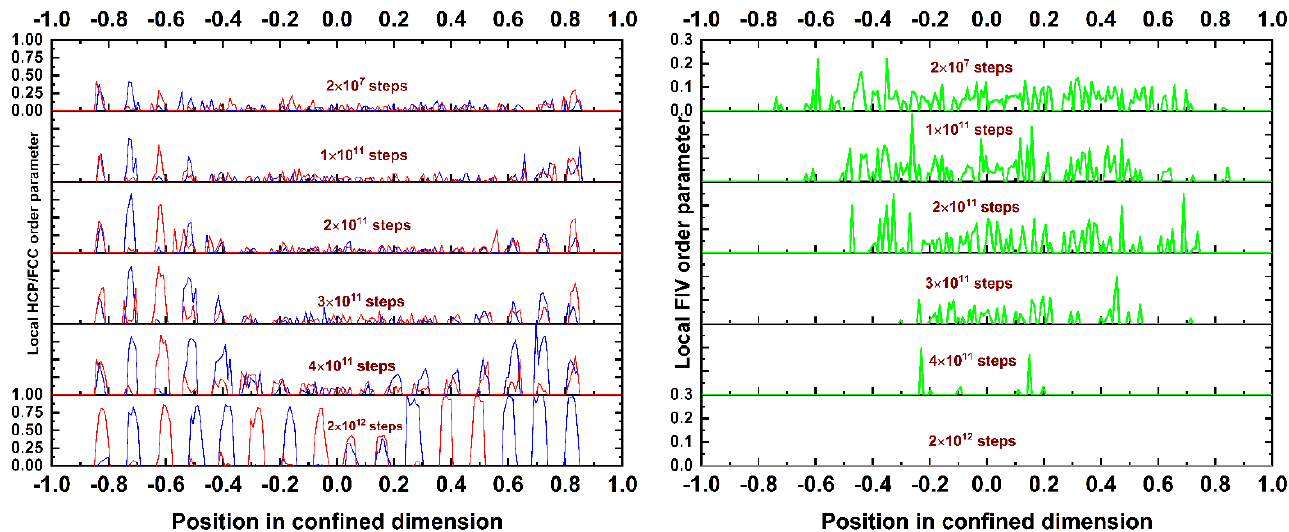
Figure 10. Stacked plots of local ( left panel ) HCP/FCC and ( right panel ) the FIV order parameter, as calculated from the CCE norm, as a function of the position in the confined dimension for the N = 100 system at ϕ = 0.60. Different plots correspond to different MC steps. Blue, red, and green correspond to the HCP, FCC, and FIV order parameters, respec- tively.